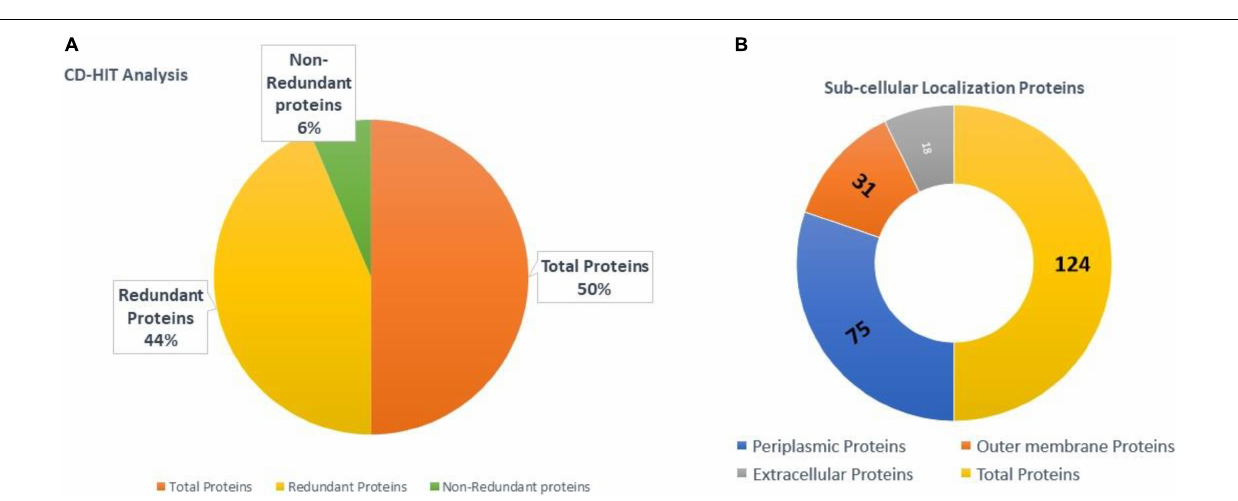
FIGURE 3 | (A) Total, non-redundant proteins, and redundant proteins of B. cepacia . (B) Categorization of surface proteins